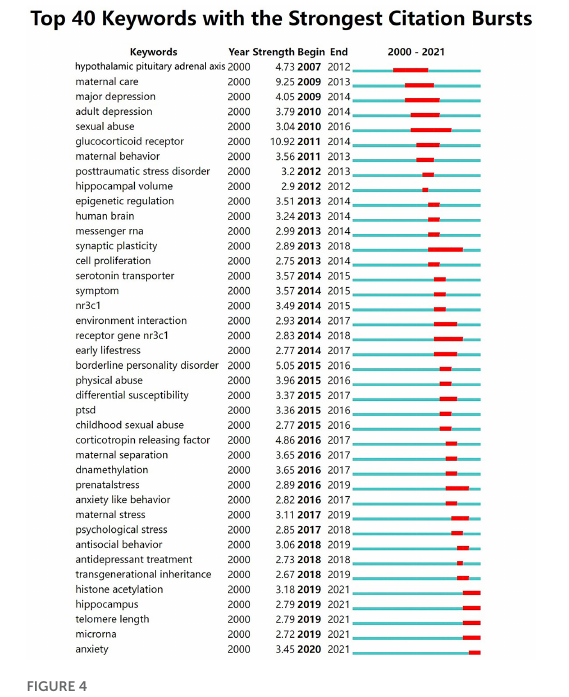
FIGURE4 Top 40 keywords with the strongest citation